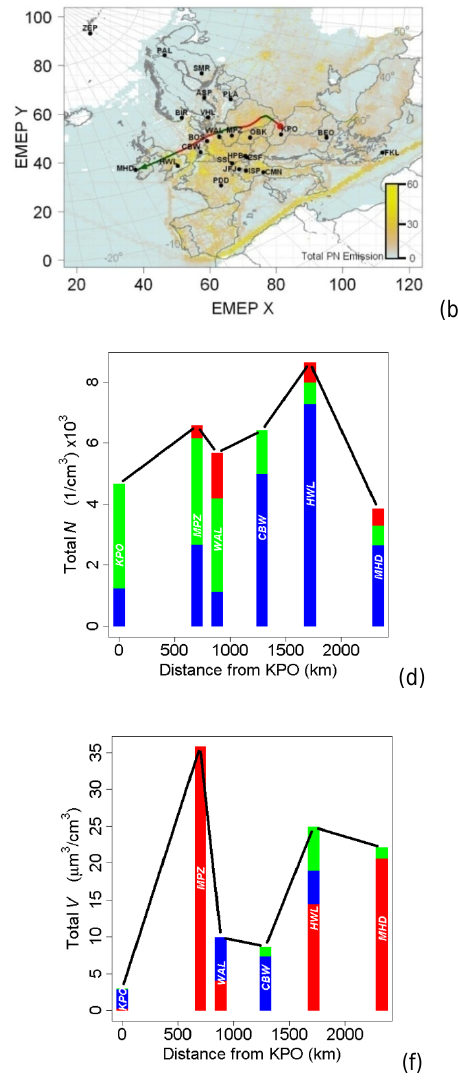
1 Fig. 9. Case study 2 (east to west). Temporal development of the particle size spectra plotted along the 5-day back-trajectory shown in plotted green/red from midnight to midnight on the particle number (PN) emission map shown in (b) , starting at KPO on 11 April 2008 and arriving at MHD on 16 April 2009 at 18:00. Spectra collected from the nearest site to the air mass path are plotted in the left middle and (c, e) . The peak fitted the modal diameters and area of each of these curves is shown on the middle and (d, f) . The middle panels correspond to the metrics derived from the number spectra and the lower panels correspond to the metrics derived from the volume spectra. The dotted lines in (c) and (e) are primarily to guide the eye, rather than being proposed as a firm causal